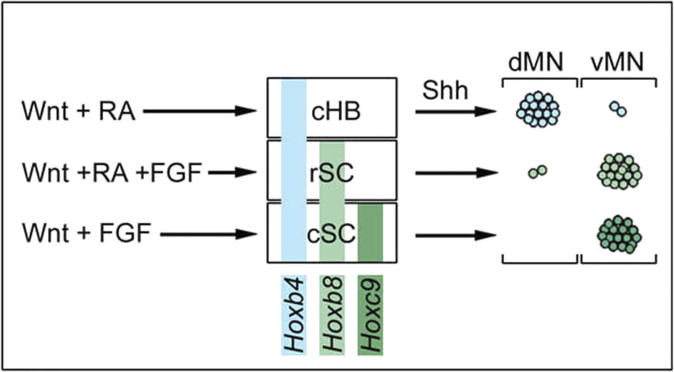
Combinatorial Wnt, retinoic acid, and FGF signals specify progenitor cell identity that prefigure motor neuron subtype in the developing hindbrain and spinal cord.